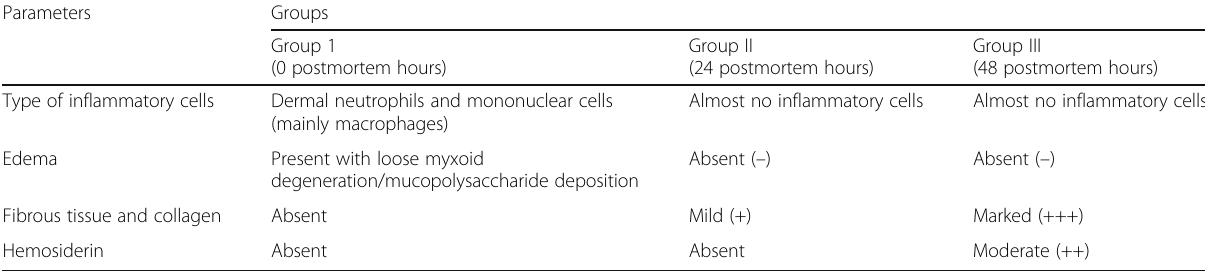
Table 1 Effect of postmortem duration on scoring of skin histopathological picture in rats ’ incisional wound